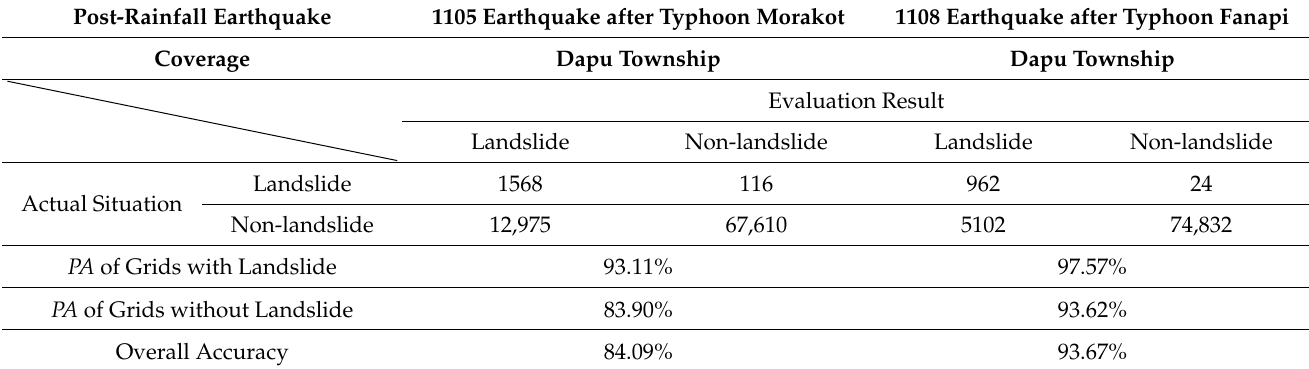
Table 10. Evaluation accuracy of postrainfall earthquake-induced landslide potential.